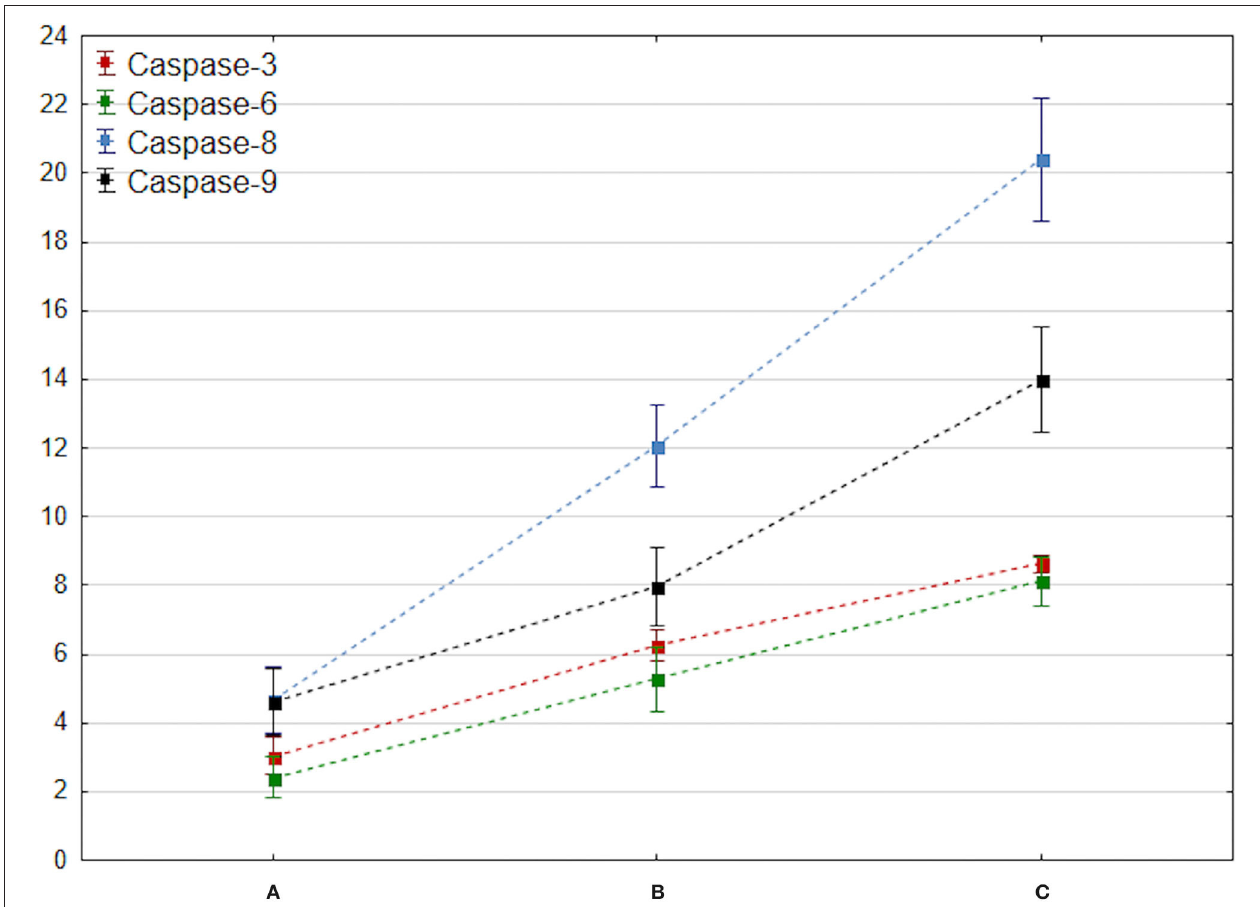
FIGURE 2 | Comparison of changes in mean caspase 3–9 values at admission, 72h, and 7 days after brain trauma. These measurement dates are marked with the letters A, B, and C and placed on the x-axis. The mean value of caspase 3–9 (y-axis) is marked with a square, while the ends of the whiskers indicate mean-95% CI and mean + 95% CI,